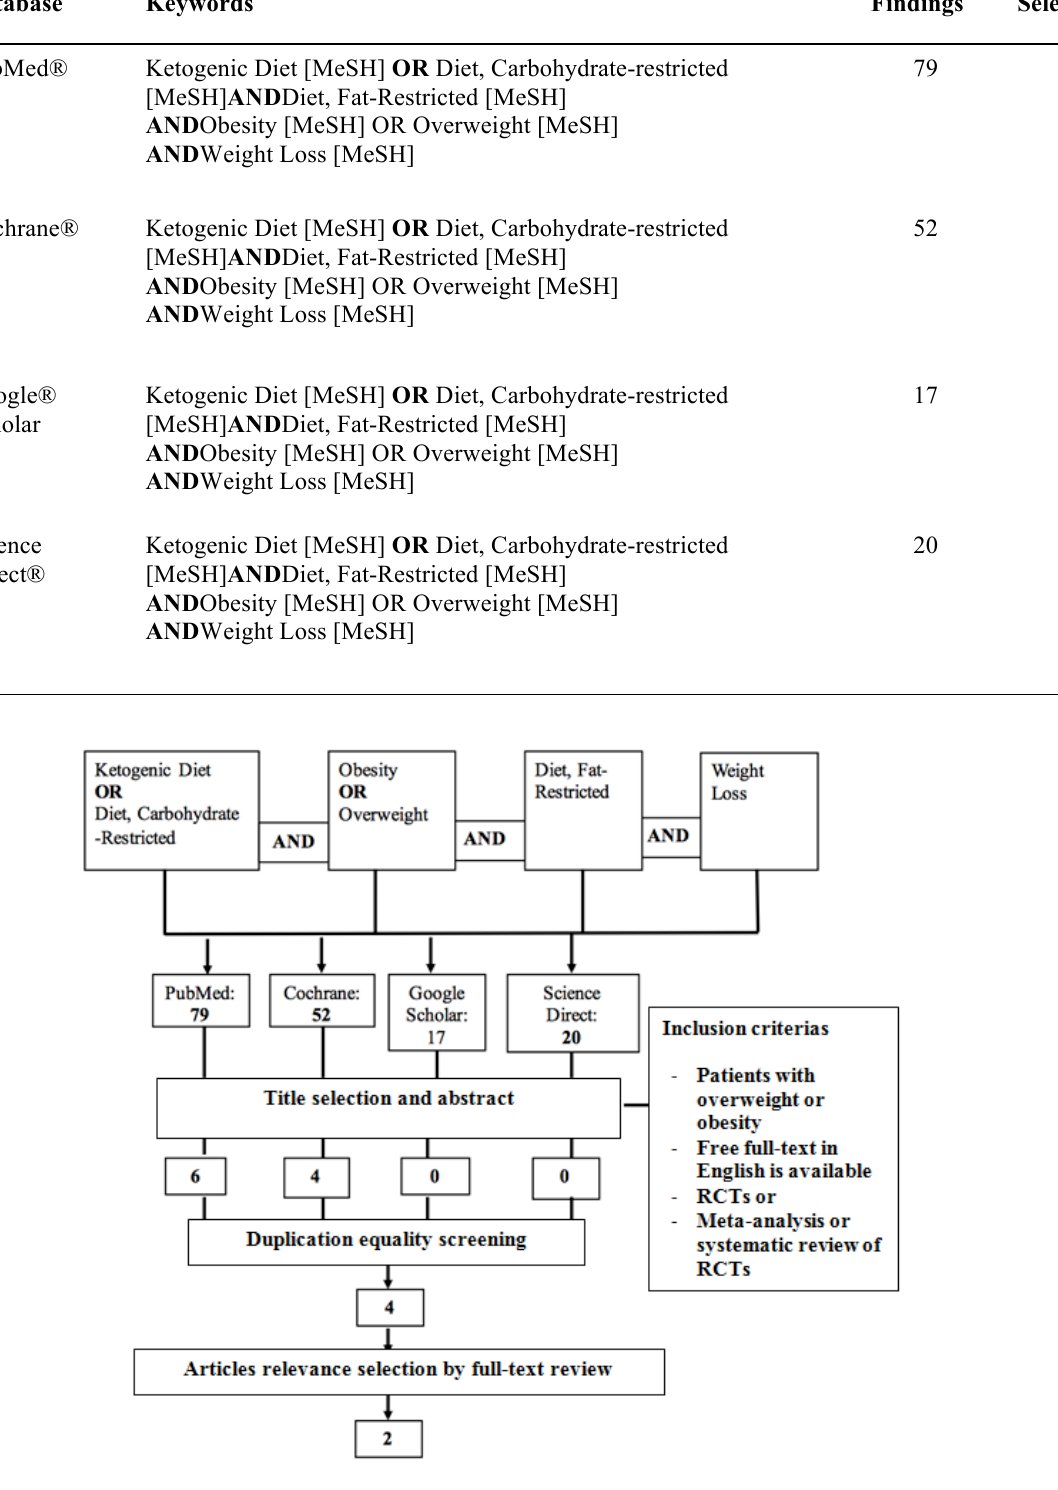
Figure 1. Flow chart of the methods used for article search and